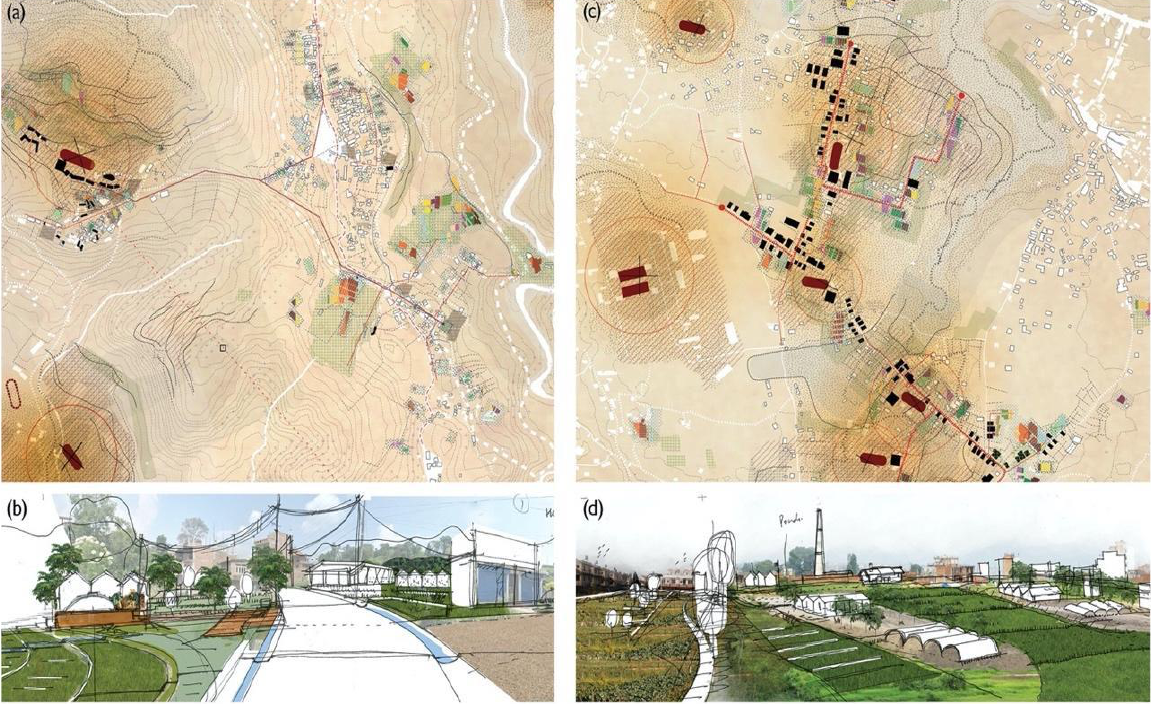
Figure 8. Sequencing the armature of connected resources and strategising village and suburban resource grids; (a) Design plan, highlighting the 'pooling' nature of the armature;(b) view of the central waste collection and processing areas within the village; (c) suburban resource grid and housing; (d) View of the central waste collection and processing areas. Source: